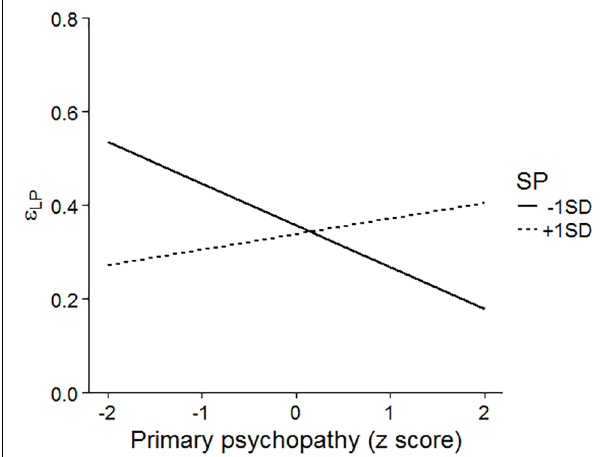
FIGURE 7 | The interaction between primary and secondary psychopathy on the learning rate for positive PE in the loss domain. SP, secondary